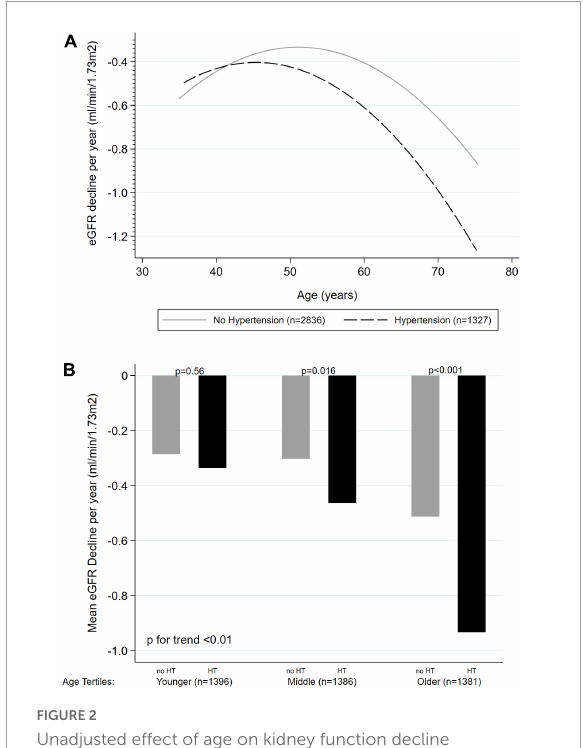
FIGURE2 Unadjusted effect of age on kidney function decline (ml/min/1.73 m 2 per year) according to hypertension status ( n = 4,163). (A) Age as a continuous variable, with quadratic fitted line. (B) Age as tertiles categories. KFD, kidney function decline; HT,